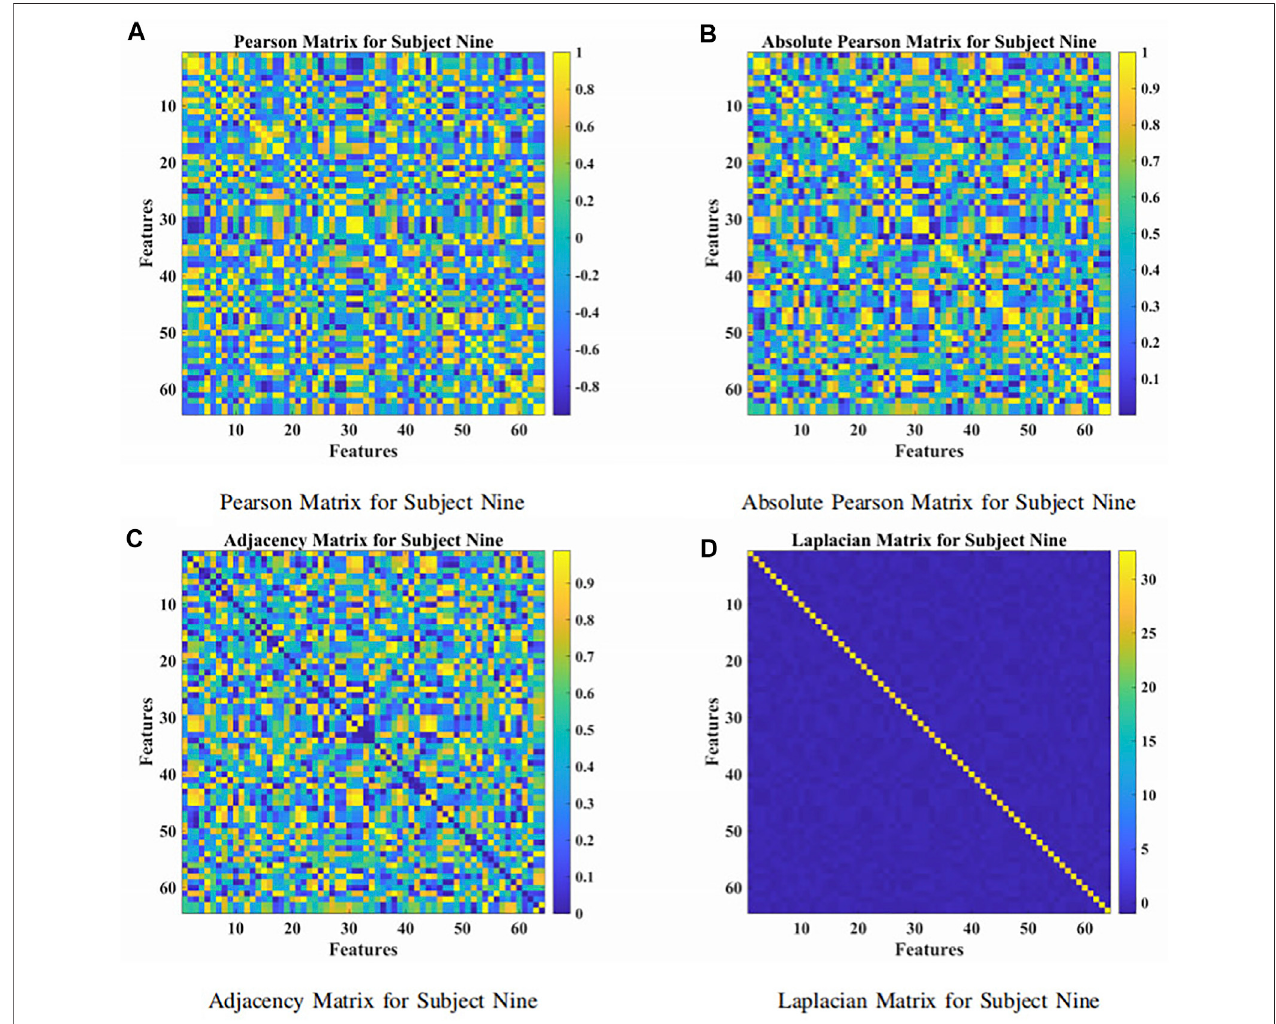
FIGURE 3 | The Pearson, absolute Pearson, adjacency, and Laplacian matrices for subject nine. (A) Pearson matrix for subject nine. (B) Absolute Pearson matrix for subject nine. (C) Adjacency matrix for subject nine. (D) Laplacian matrix for subject nine.